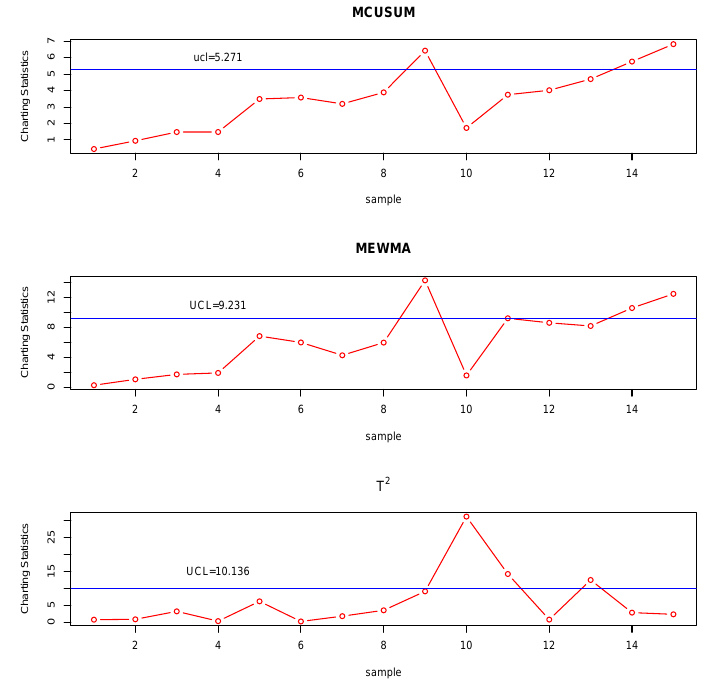
Figure 8. MCUSUM, MEWMA, and T 2 control charts under intercept shift coefficient of